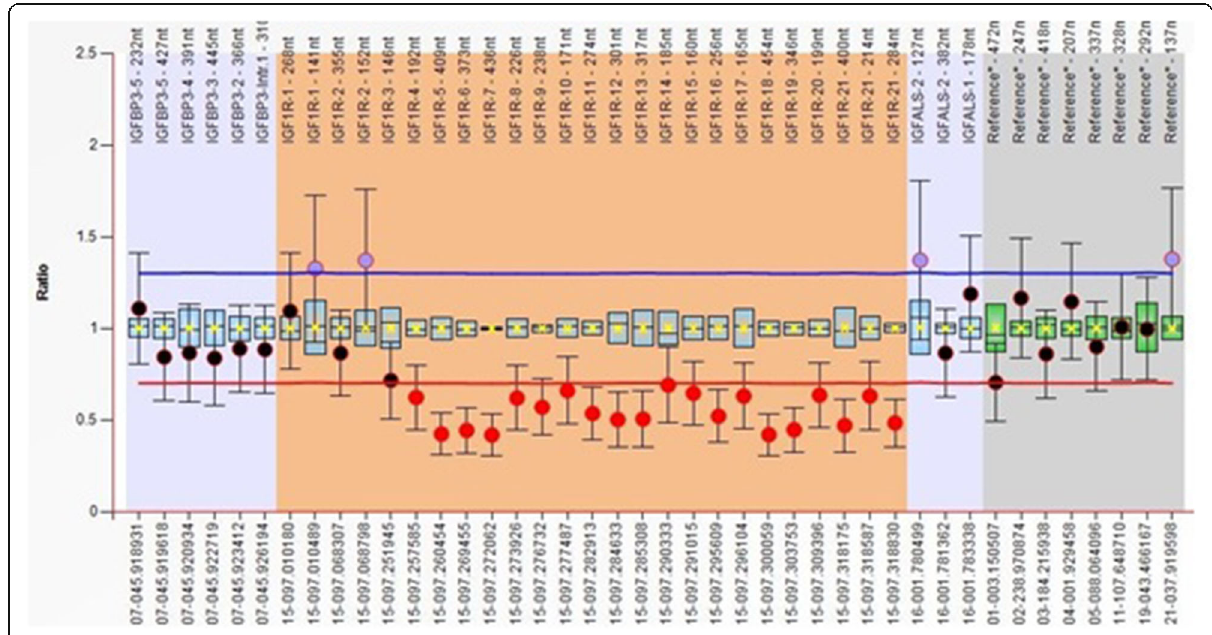
Fig. 1 Ratio chart of MLPA results for a patient with short stature using SALSA MLPA probemix P217-B2 IGF1R. The chart shows the heterozygous deletion of IGF1R (exons 4 through 21). The deletion is denoted by the red spot below the deletion cut-off line (red) in the ratio